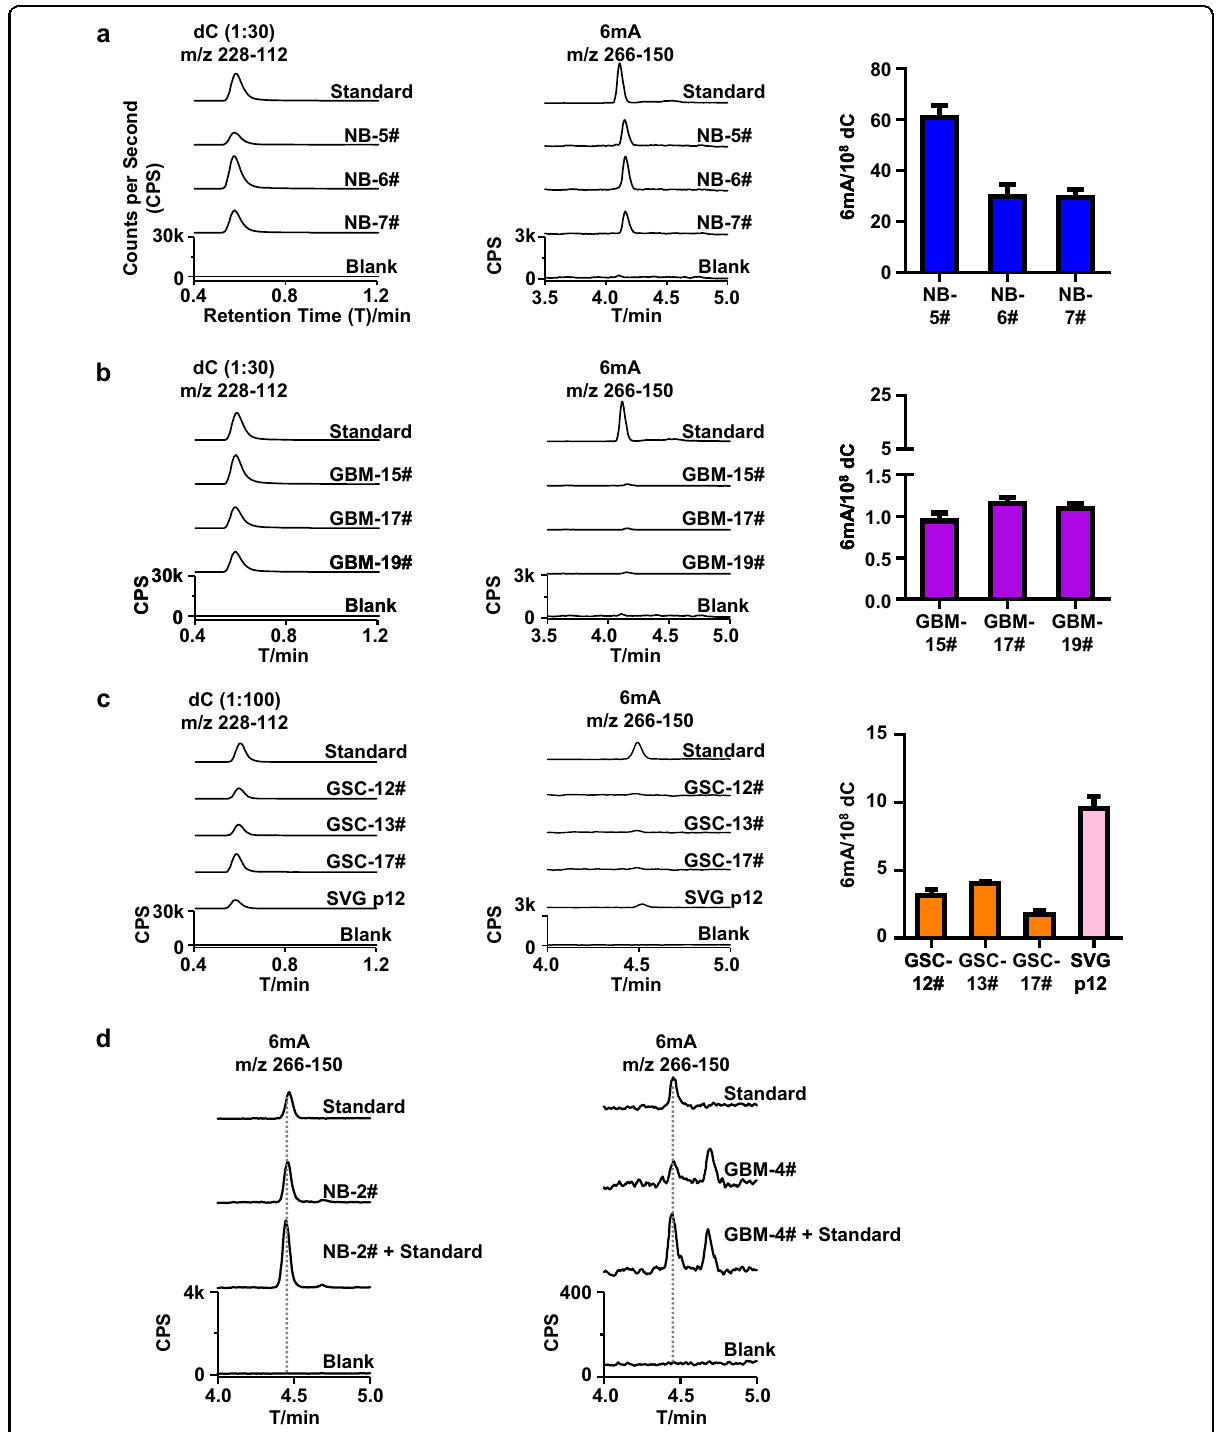
Fig. 1 Identi fi cation of DNA 6mA in human normal brain tissues and glioblastomas. a – c UHPLC-MS/MS chromatograms and quanti fi cation of DNA dC and 6mA in normal brain (NB) tissues ( a ), Glioblastoma (GBM) ( b ), and Glioblastoma Stem Cells (GSCs) and glial cell line (SVG p12) ( c ). d UHPLC-MS/MS chromatograms of DNA 6mA in the genome of control brain tissues (NB-2#, ~22 6mA per 10 8 dC) spiked with or without 6mA standard (~13 6mA per 10 8 dC) and in the genome of GBM-4# (~1.2 6mA per 10 8 dC)) spiked with or without 6mA standard (~1.2 6mA per 10 8 dC). Blank: ultrapure water underwent the puri fi cation and digestion as same as real